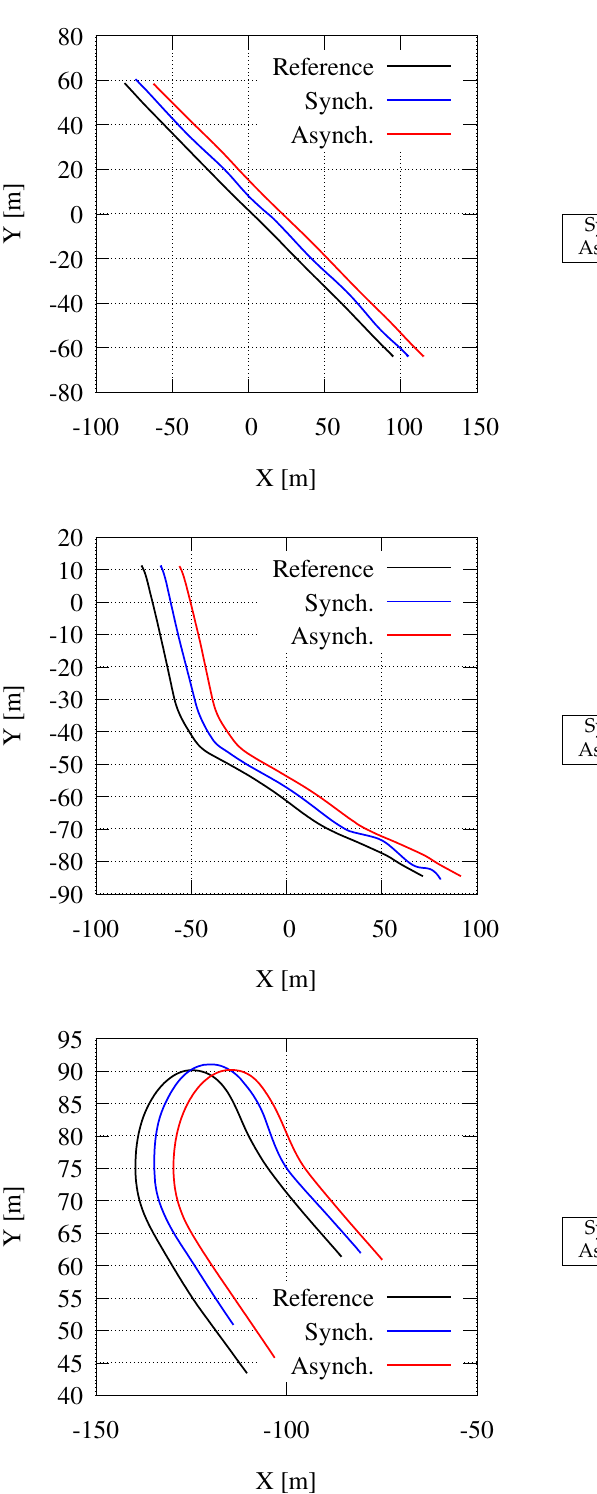
Figure 14. A comparison between the reference trajectory (the one to follow) and the paths generated using the synchronous and asynchronous communication schemes along a straight road ( top ), a mild bend ( center ), and a high curvature trajectory ( bottom ). The reference path and the ones gathered with synchronous and asynchronous working are displaced by 10 m along the x-axis for readability. The error metrics (CRMSE and MBE), and target diagrams are reported in the center table and on the right-hand side